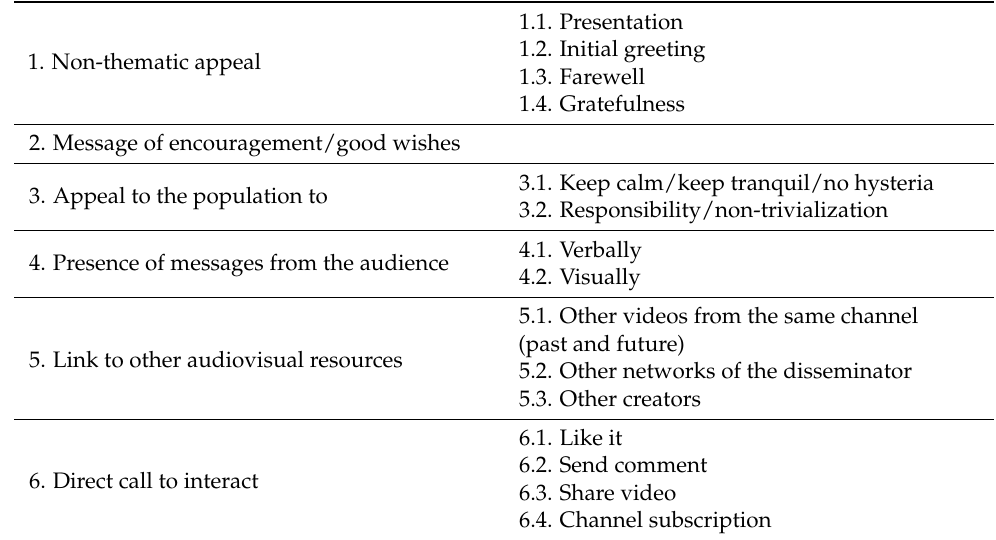
Figure 2. Marker of scientific evidence from Diario de un MIR. Table 4. Codebook for the analysis of the interaction with the